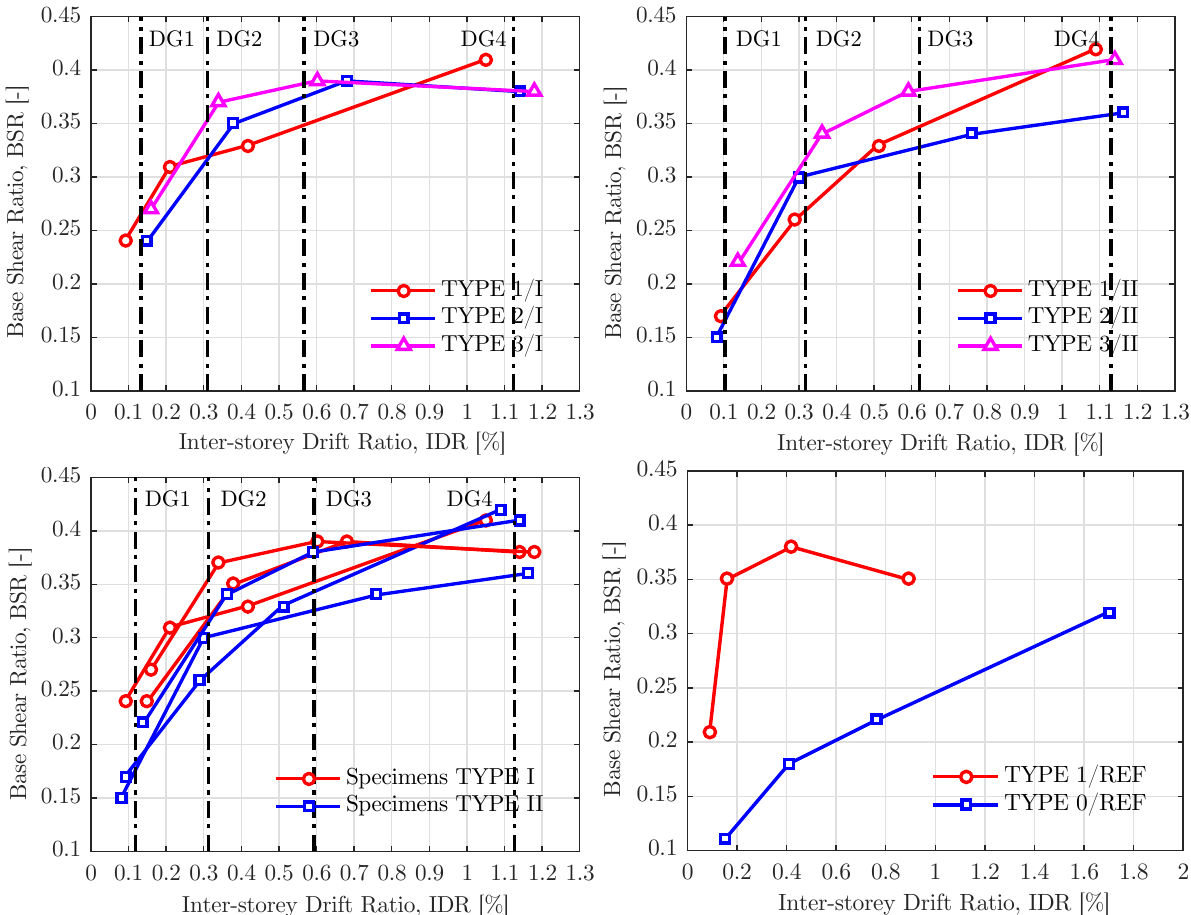
Figure 7. Trends of damage formation for all tested specimens with marked average damage limits in accordance with the